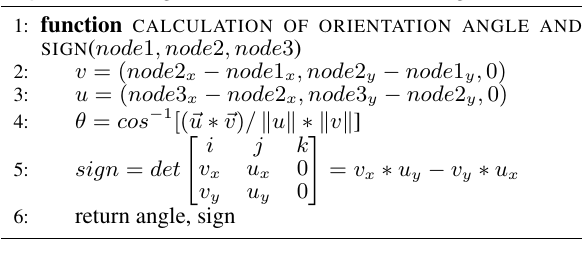
Algorithm 1 Dijkstra’s algorithm